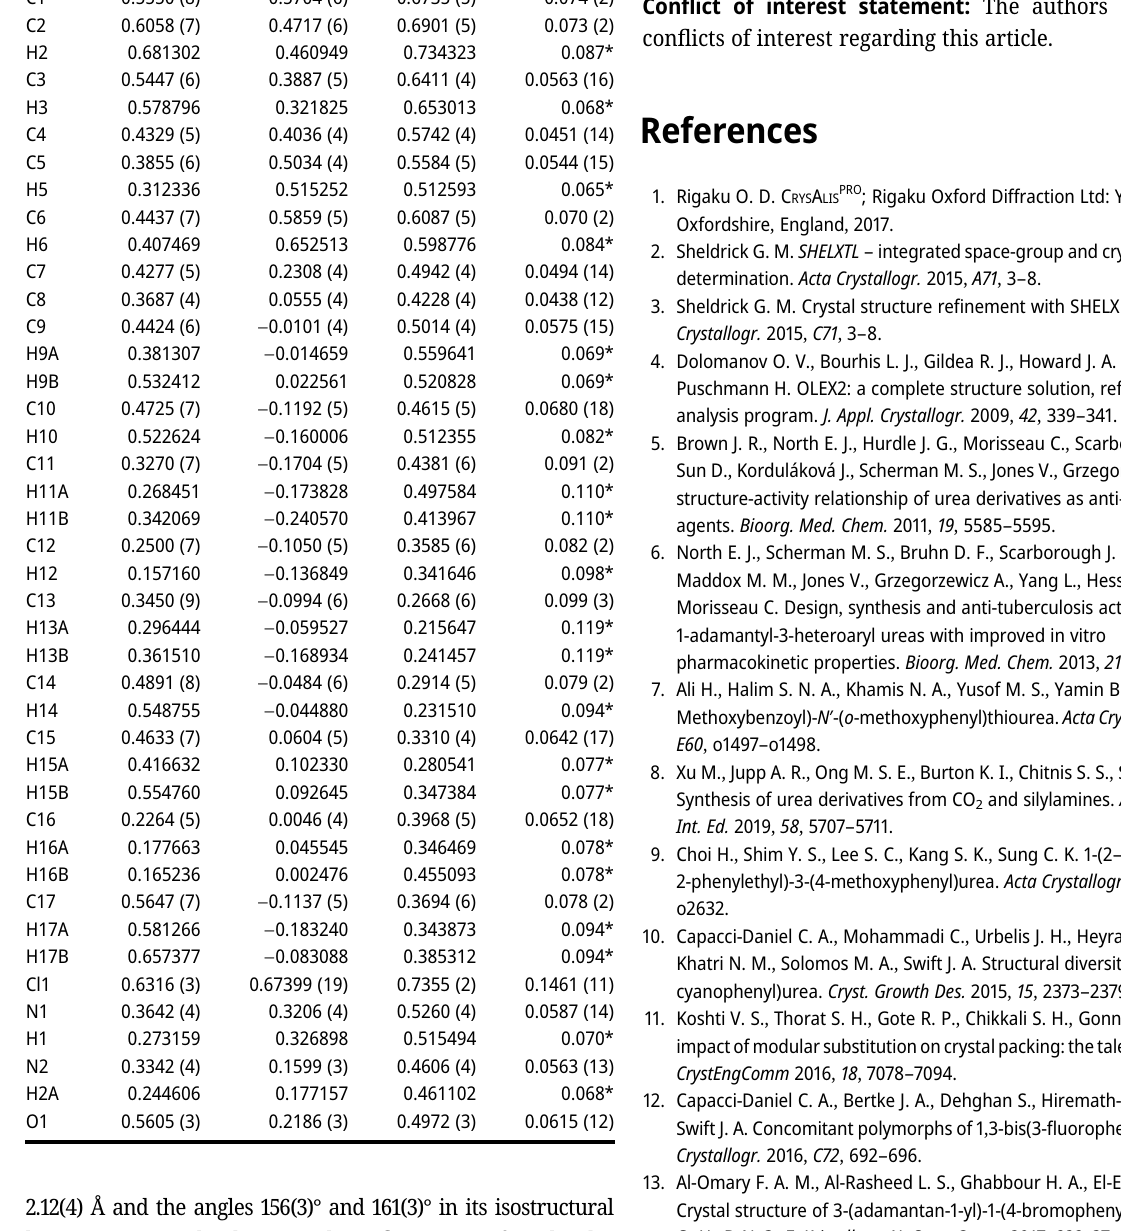
2.12(4) Å and the angles 156(3) ° and 161(3) ° in its isostructural bromo compound. The crystal con fi guration of molecules compound crystals [7 – 12]. In addition, the molecule conforma- tion, including bond lengths, angles, and torsion angles of the adamantane ring system and the 4-chlorophenyl group, are consistent with previously published structures [14, 15].